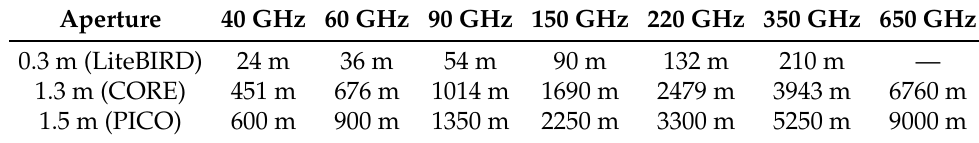
Table 1. Far Field Distance for different telescope apertures and frequency bands.